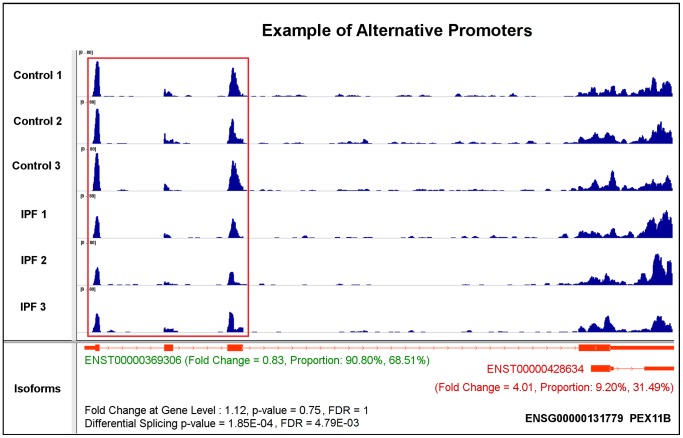
A case study of gene PEX11B as demonstration of the alternative promoters splicing mechanism using the annotated transcripts.